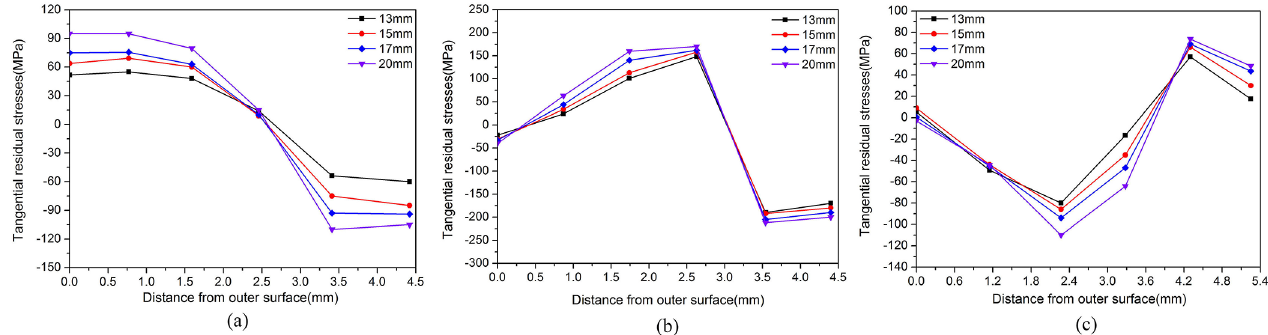
Fig. 10. Tangential residual stress distribution in the (a) cup bottom, (b) cup wall and (c) die entrance radius of square cups under various die entrance